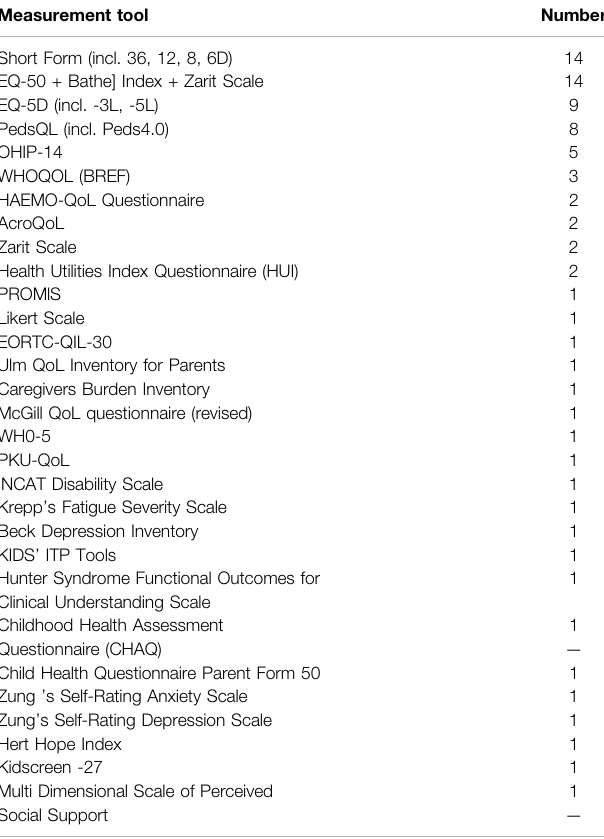
TABLE 2 | QoL measurement tools used in reviewed QoL